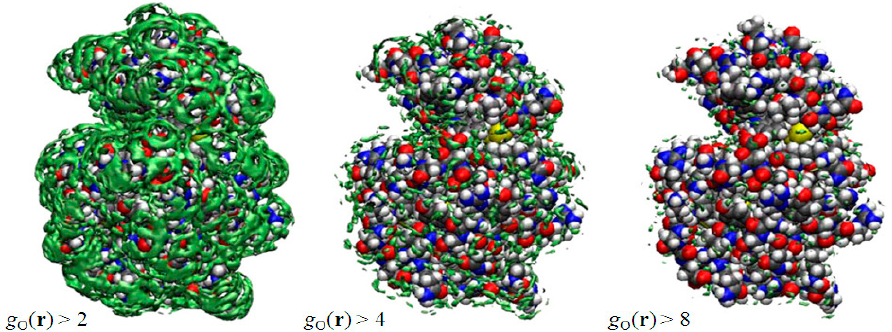
Figure 2. 3D-distribution g( r ) of water around a protein (lysozyme). (The figure is reprinted from Ref. [46]. Copyright (2005) American Chemical Society.)